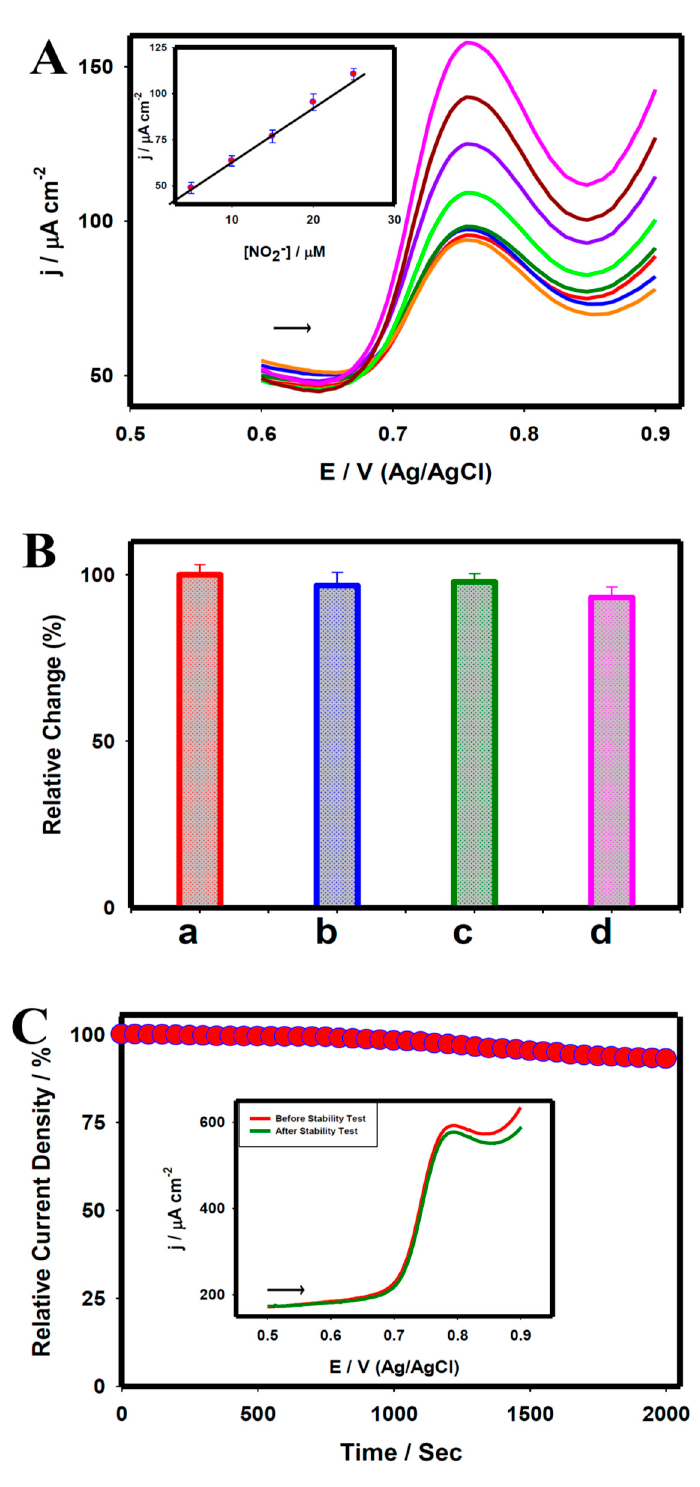
Figure 7. ( A ) Differential pulse voltammograms (DPVs) recorded for the PtW/rGO-IL nanocomposite electrode in 5 µM of NO 2 − (red) and a mixture with 50 µM of dopamine (DA, blue), DA + ascorbic acid (AA, dark green), DA + AA + uric acid (UA pink), and 10 (green), 15 (purple), 20 (brown) and 25 µM of NO 2 − (pink). Inset: The corresponding calibration plot; ( B ) The plot of the relative response of 5 µM of NO 2 − (a) and mixture with 50 µM of DA (b), DA + AA (c), DA + AA + UA (d); ( C ) Amperometric responses of the PtW/rGO-IL nanocomposite electrode recorded in 1 mM of NO 2 − (Eapp:0.78 V). Inset: linear sweep voltammograms (LSVs) recorded the PtW/ rGO-IL nanocomposite electrode prior to and following the stability tests in 1 mM of NO 2 − [87]. Copyright 2016, Springer.